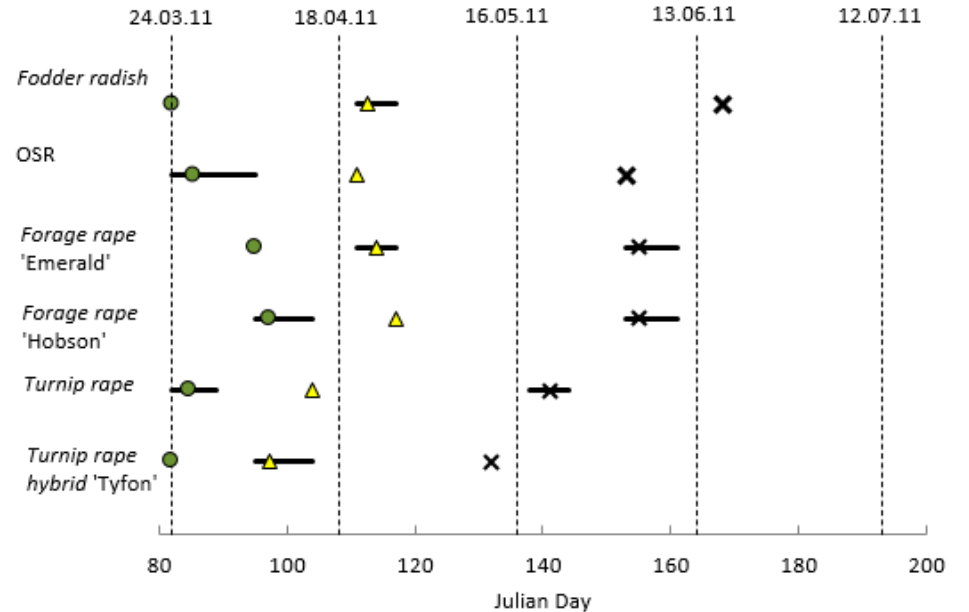
Figure 1. Key brassica plant growth stages relative to suction sample dates (dotted lines), averaged over four plots of each Brassicaceae treatment † ; horizontal bars represent the range of dates over which the key growth stages were attained. Filled green circles: ≥ 25% of plants at GS 51 (green bud); filled yellow triangles: ≥ 25% of plants at GS 60 (onset of flowering); crosses (x): flowering finished for ≥ 95% of plants. † Brassicaceae treatments: Fodder radish ( Raphanus sativus ) cv Apoll; Oilseed rape (OSR; Brassica napus ) cv Castille; Forage rape ( Brassica napus ) cv Emerald and cv Hobson; Turnip rape ( Brassica rapa ) cv Jupiter and Tyfon (hybrid of B. rapa Rapifer group × B. rapa Pekinensis group).